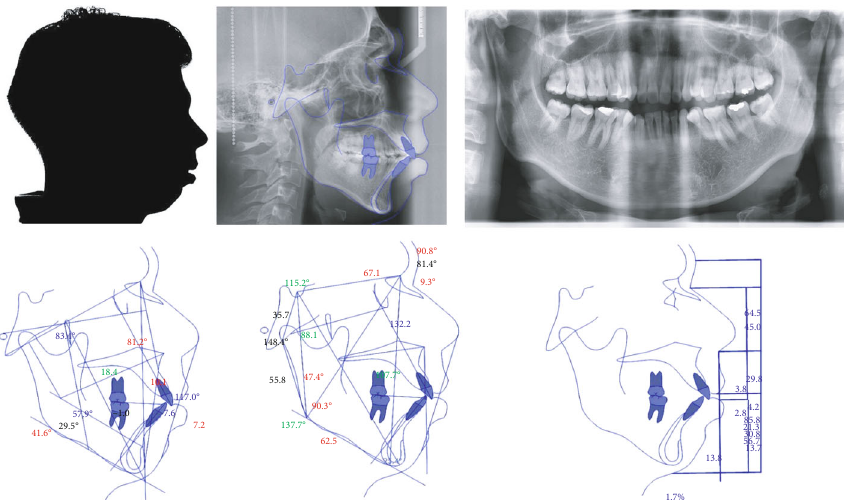
Figure 6: Radiographic study (cranial lateral radiography and orthopantomography) and cephalometry (Ricketts analysis, Jarabak analysis, and soft pro fi le analysis) of the patient, necessary for the diagnosis of the patient.